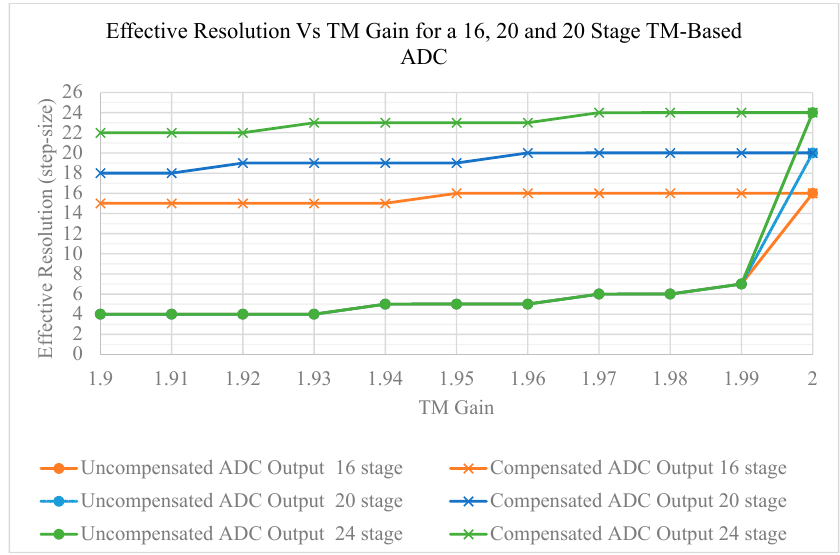
Figure 14. Effect of the compensation algorithm on effective resolution. Figure 14. E ff ect of the compensation algorithm on e ff ective resolution.